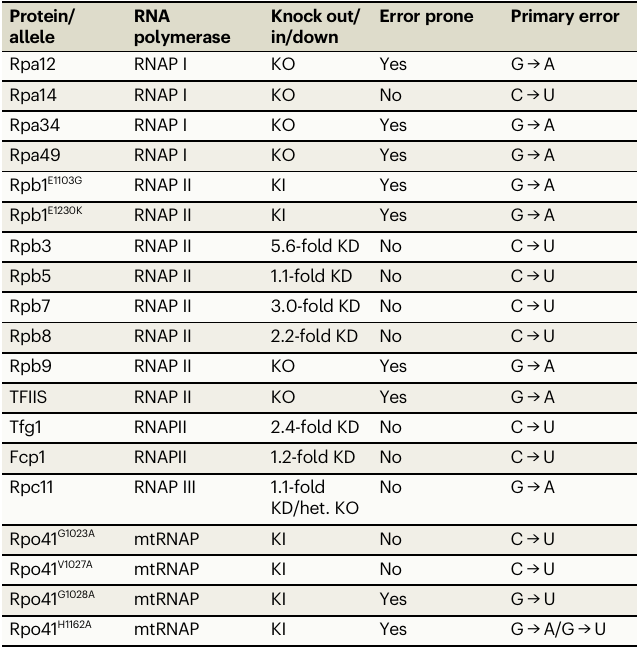
Table 1 | Yeast proteins and alleles monitored for their con- tribution to transcriptional fi delity Protein/ RNA Knock out/ Error prone Primary allele polymerase in/down